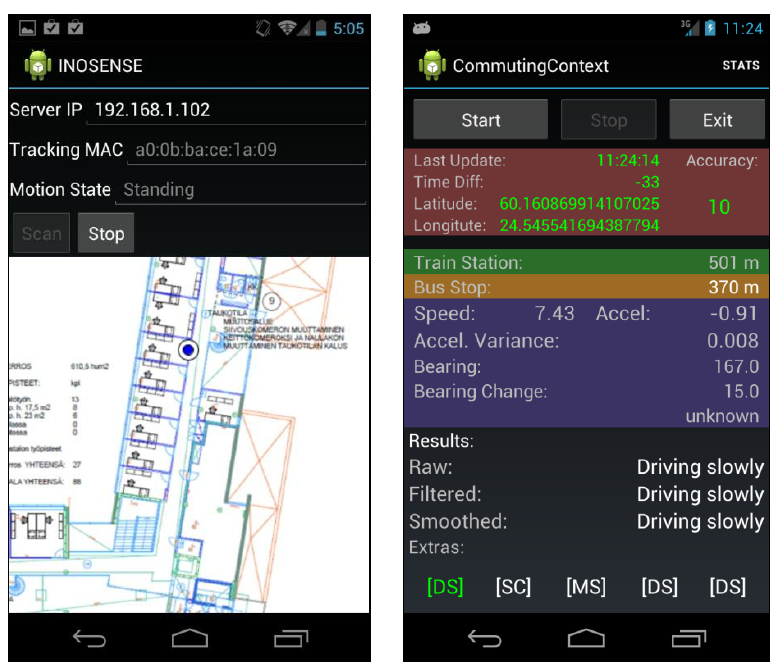
Figure 4. Application